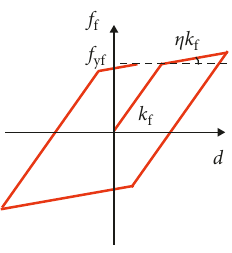
Figure 5: Hysteresis model of the